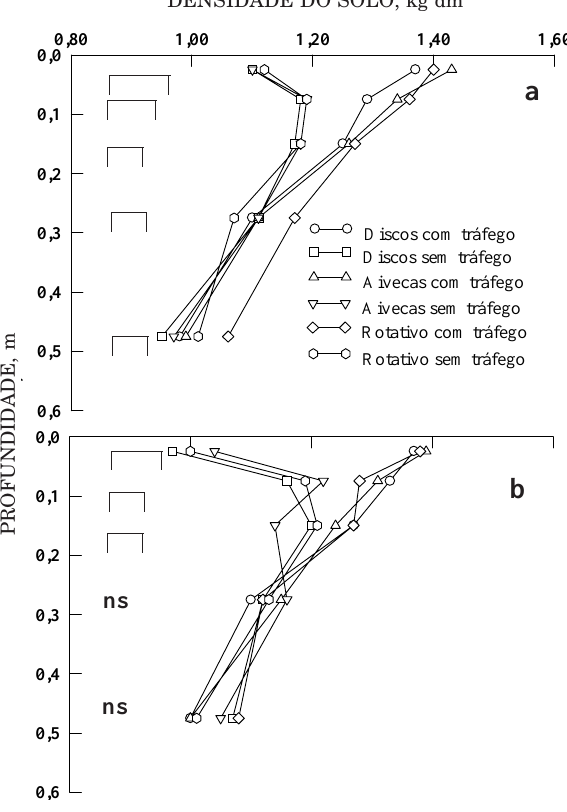
Figura 1. Densidade do solo determinada nas coletas realizadas em março de 1990 (a) e maio de 1991 (b). (As barras horizontais indicam as diferenças mínimas significativas entre os tratamentos obtidas pelo teste de Tukey (p < 0,01) e ns indica ausência de diferenças entre os